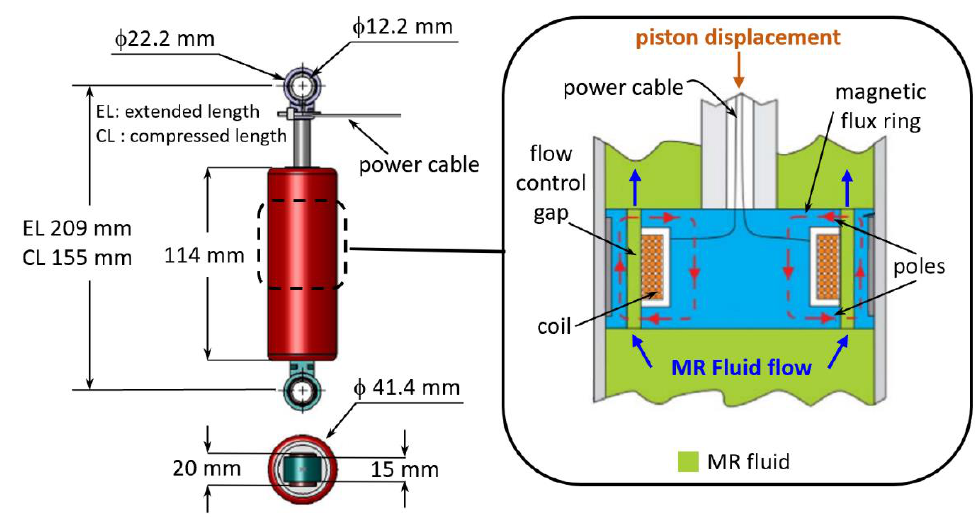
Figure 22. LORD MRD-1005-3: main dimensions and sketch of the working principle.